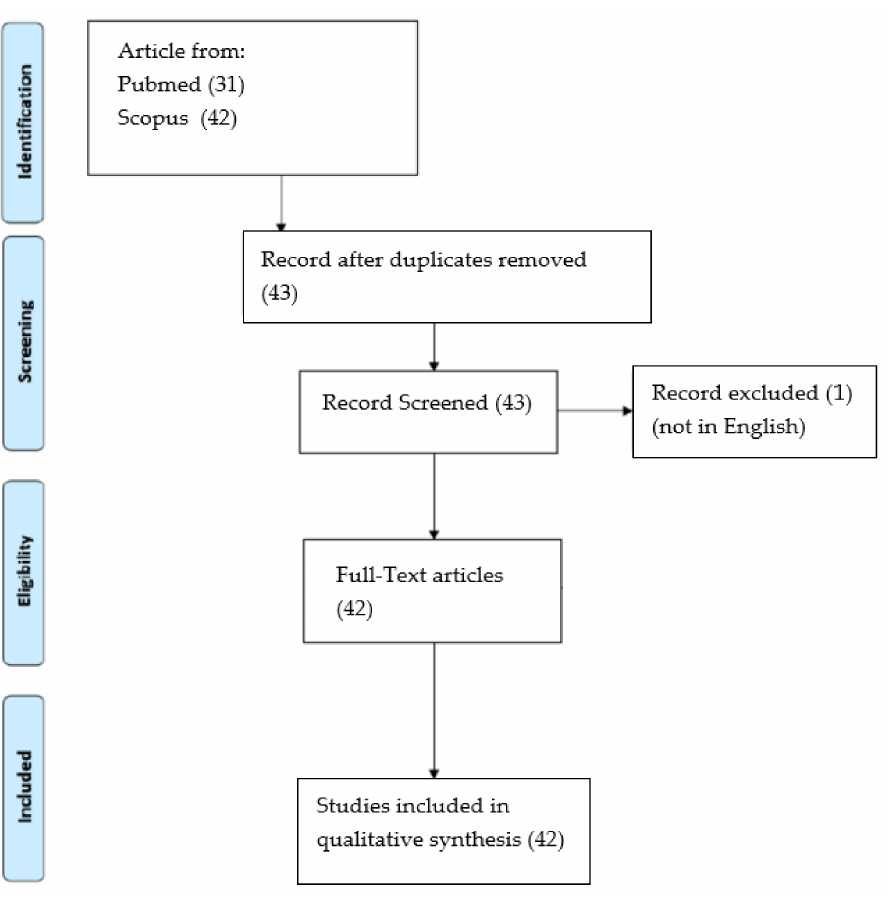
Figure 1. PRISMA Search flow results